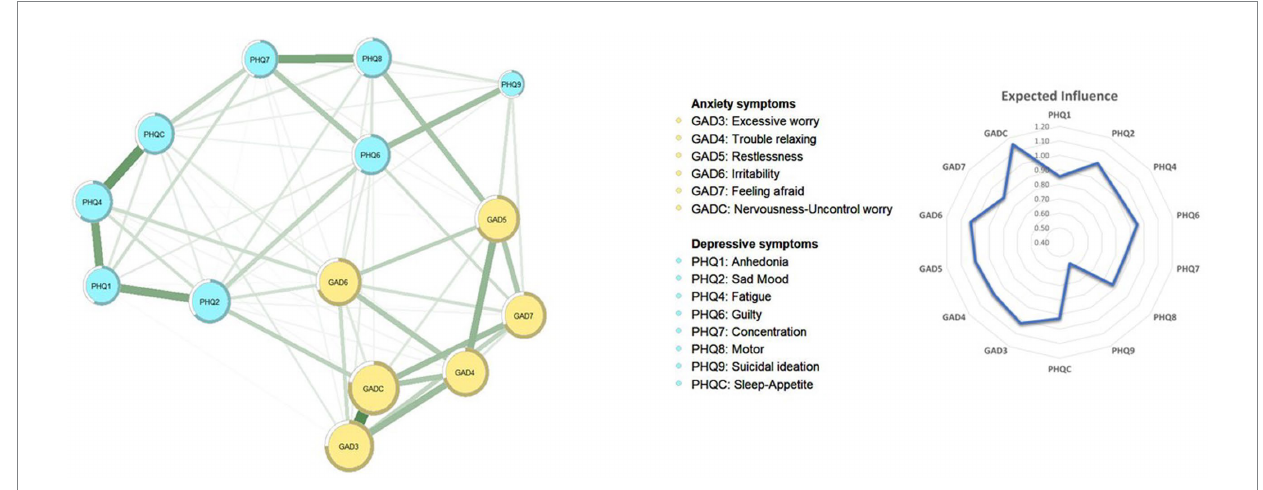
FIGURE 1 The network structure of depression and anxiety model in Macau